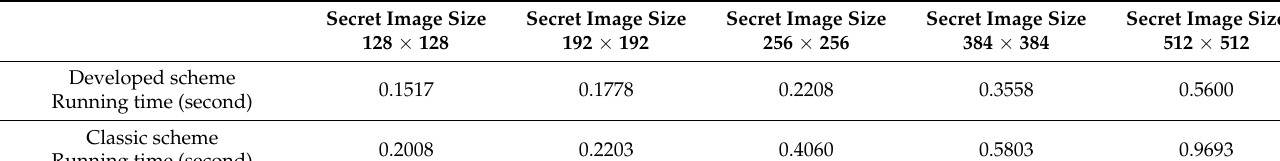
Figure 8. Running time comparison chart with different size in GF (2 8 ).